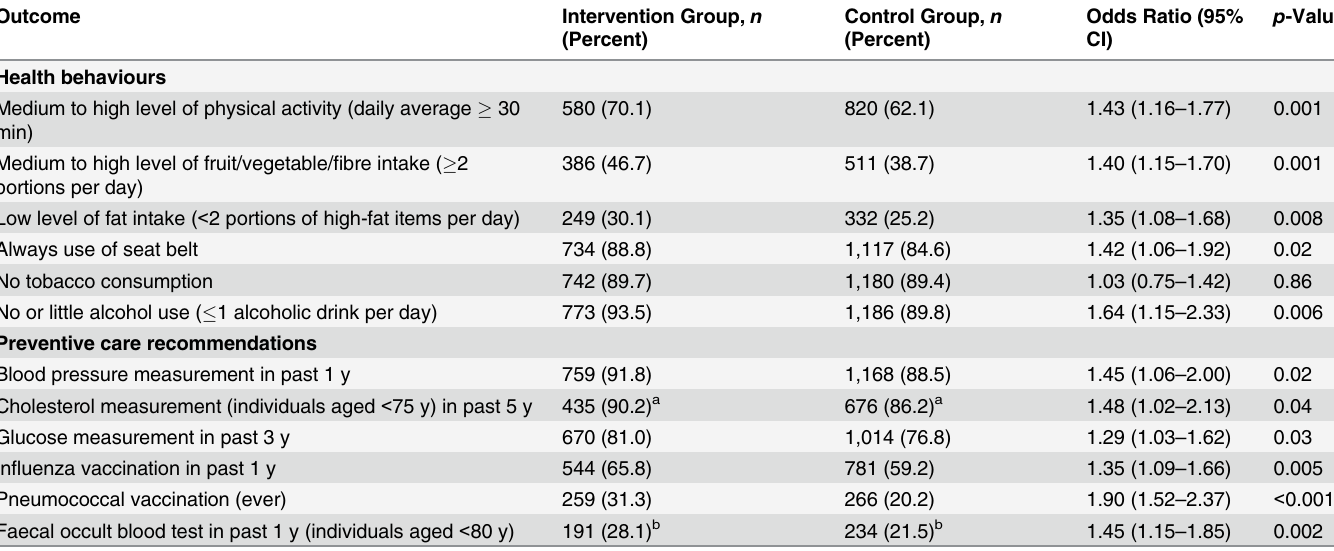
Table 4. Primary outcomes at 2-y follow-up: health behaviours and adherence to preventive care